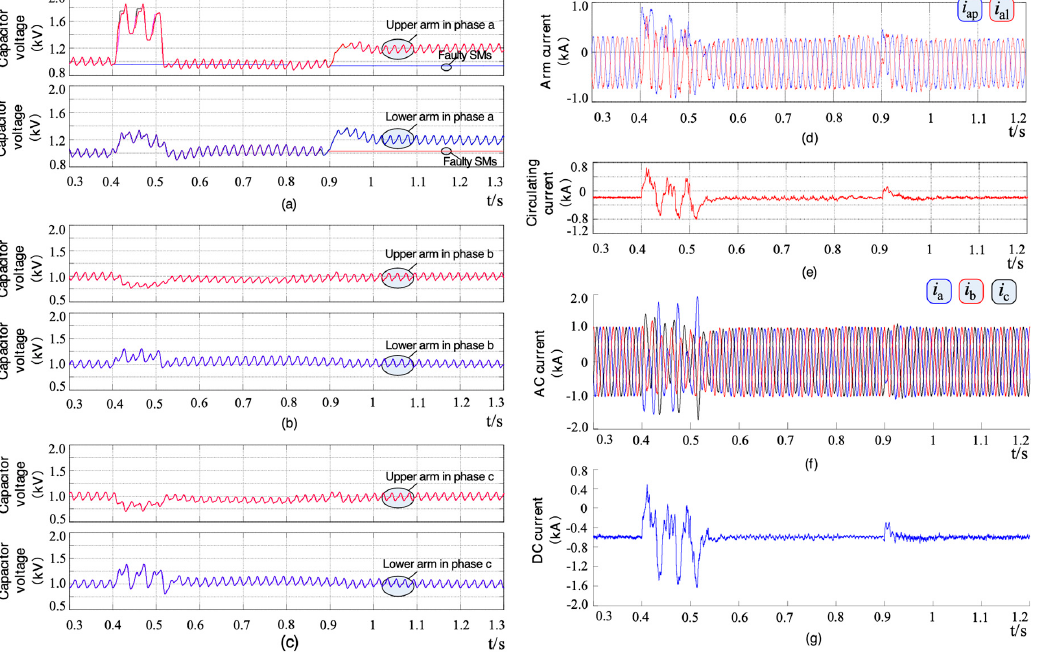
Figure 10. Simulation results of fault condition 2: ( a ) Capacitor voltage of phase a; ( b ) Capacitor voltage of phase b; ( c ) Capacitor voltage of phase c; ( d ) Arm current of phase a; ( e ) Circulating current of phase a; ( f ) AC current; ( g ) DC-link